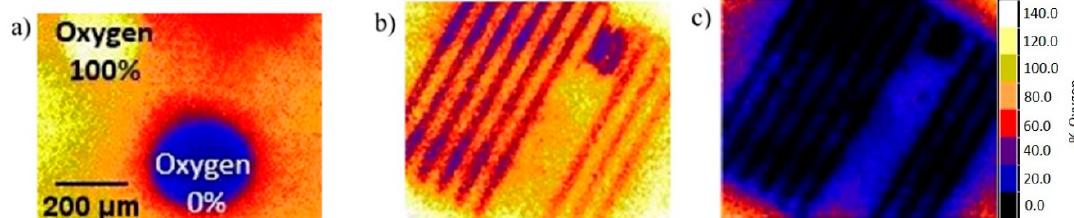
Figure 9. Oxygen measurements of microchip on oxygen sensor foil. ( a ) Calibration of oxygen on oxygen sensor foil with standards: oxygen-depleted water (0% oxygen: black colour) and oxygen saturated water (100% oxygen: white colour). ( b ) Oxygen signal from pumping one channel with oxygen depleted water. ( c ) Oxygen signal from pumping two channels with oxygen depleted water.